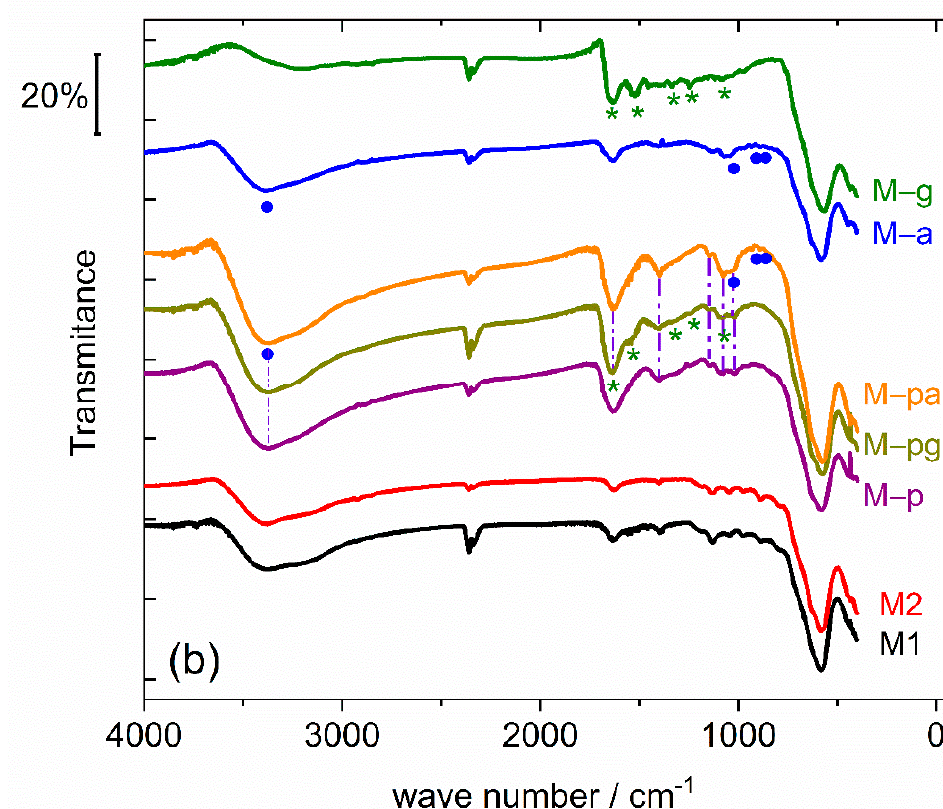
Figure 2. ( a ) FTIR spectra of gelatin, agar ‐ agar and Pectigel (pectin ‐ containing food ‐ grade additive) and ( b ) of the various synthesized powders. Some of the spectra are displaced vertically for better visualization, and the peaks considered associated with the different additives are marked by green stars (gelatin), blue circles (agar ‐ agar) and violet diamonds/dash ‐ dot lines in the case of Pectigel/pec ‐ tin.